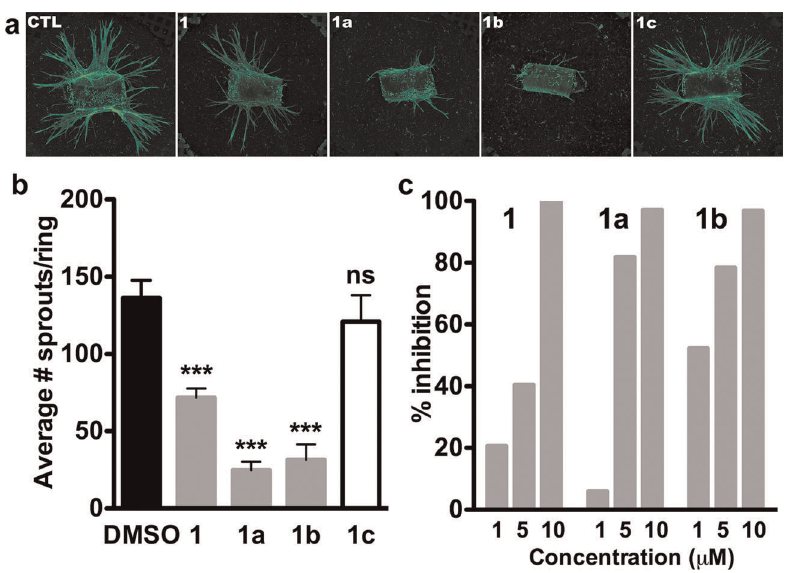
Figure 7. EYA inhibitors attenuate sprouting angiogenesis. ( a ) Representative images of aortic rings treated with either the vector control (0.1% DMSO) or 5 m M of compounds 1, 1a, or 1b. Rings were stained with isolectin. 1c is used as a negative control as it does not inhibit EYA. ( b ) Quantitation of the number of sprouts per ring is included; each bar represents the mean of 6 rings. p-values from a one-way ANOVA are shown; ns is not significant, * p , 0.05, ** p , 0.01, *** p , 0.001. ( c ) Compounds 1, 1a, and 1b in the indicated doses were used in aortic ring experiments. The number of sprouts per ring is plotted indicating that inhibition of aortic sprouting was dose-dependent.